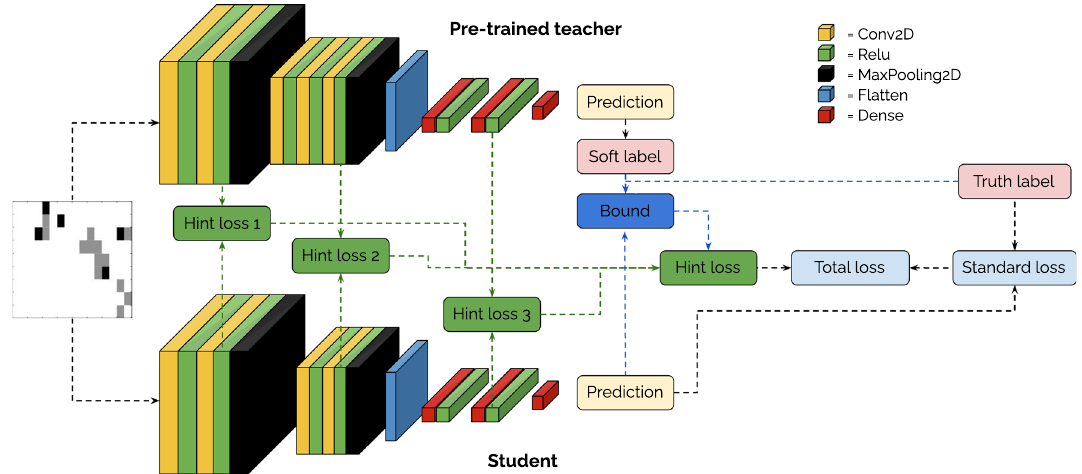
Fig. 5 Schematic view of the Student model training, receiving hints from the Teacher model. Adaptation layer are present in each of the hint loss